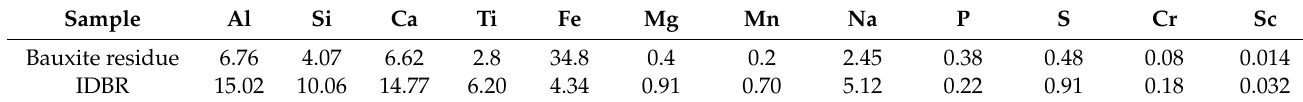
Table 1. Chemical composition of the IDBR sample, wt.%.